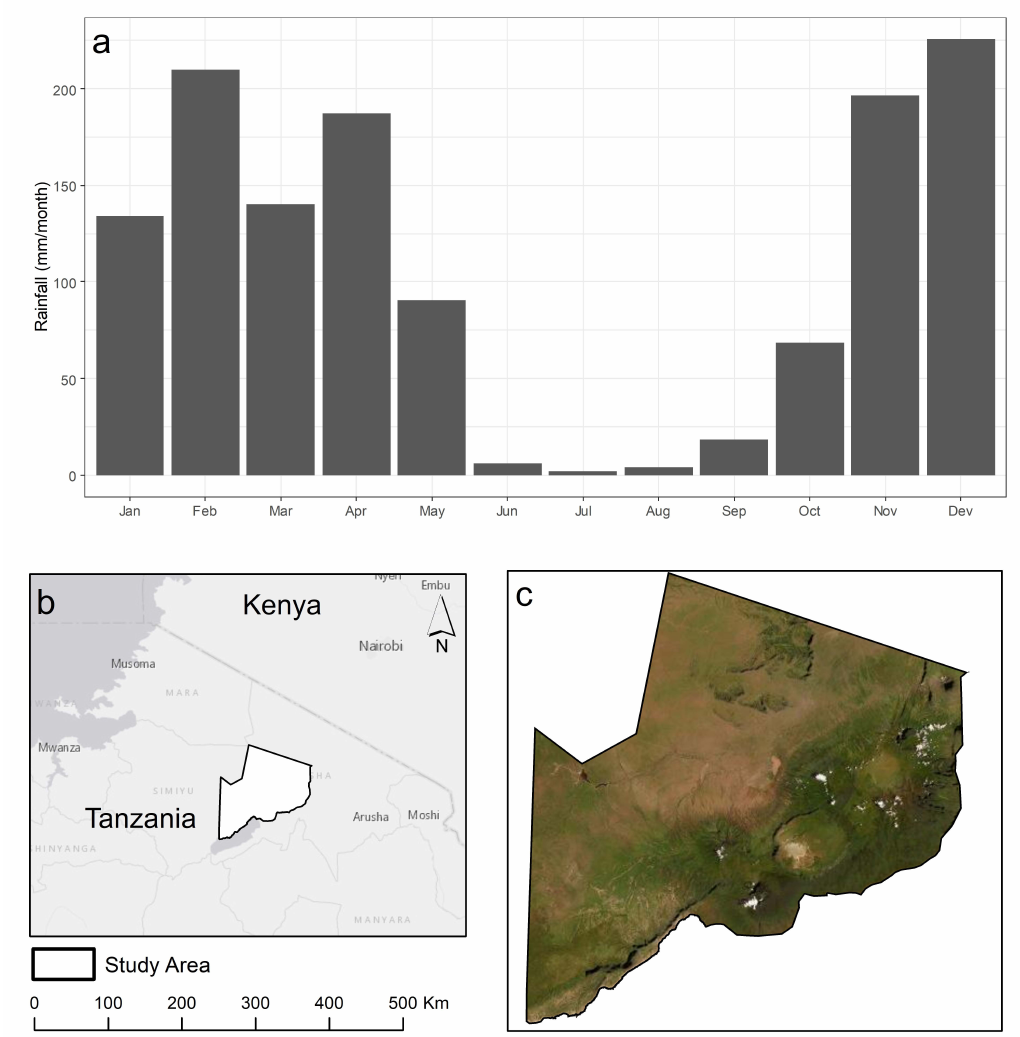
Figure 1. ( a ) ECMWF (European Center for Medium-Range Weather Forecasts) Re-Analysis (ERA) rainfall average in the study area for 2018 / 2019, ( b ) location of the study area in East Africa, ( c ) Ngorongoro Conservation Area, Tanzania from Google Earth (Digital